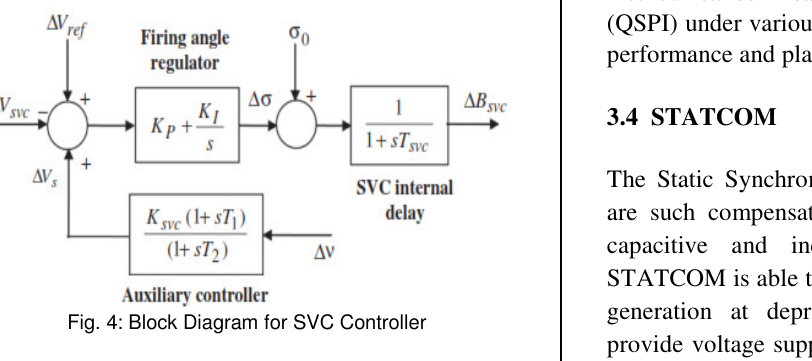
Fig. 4: Block Diagram for SVC